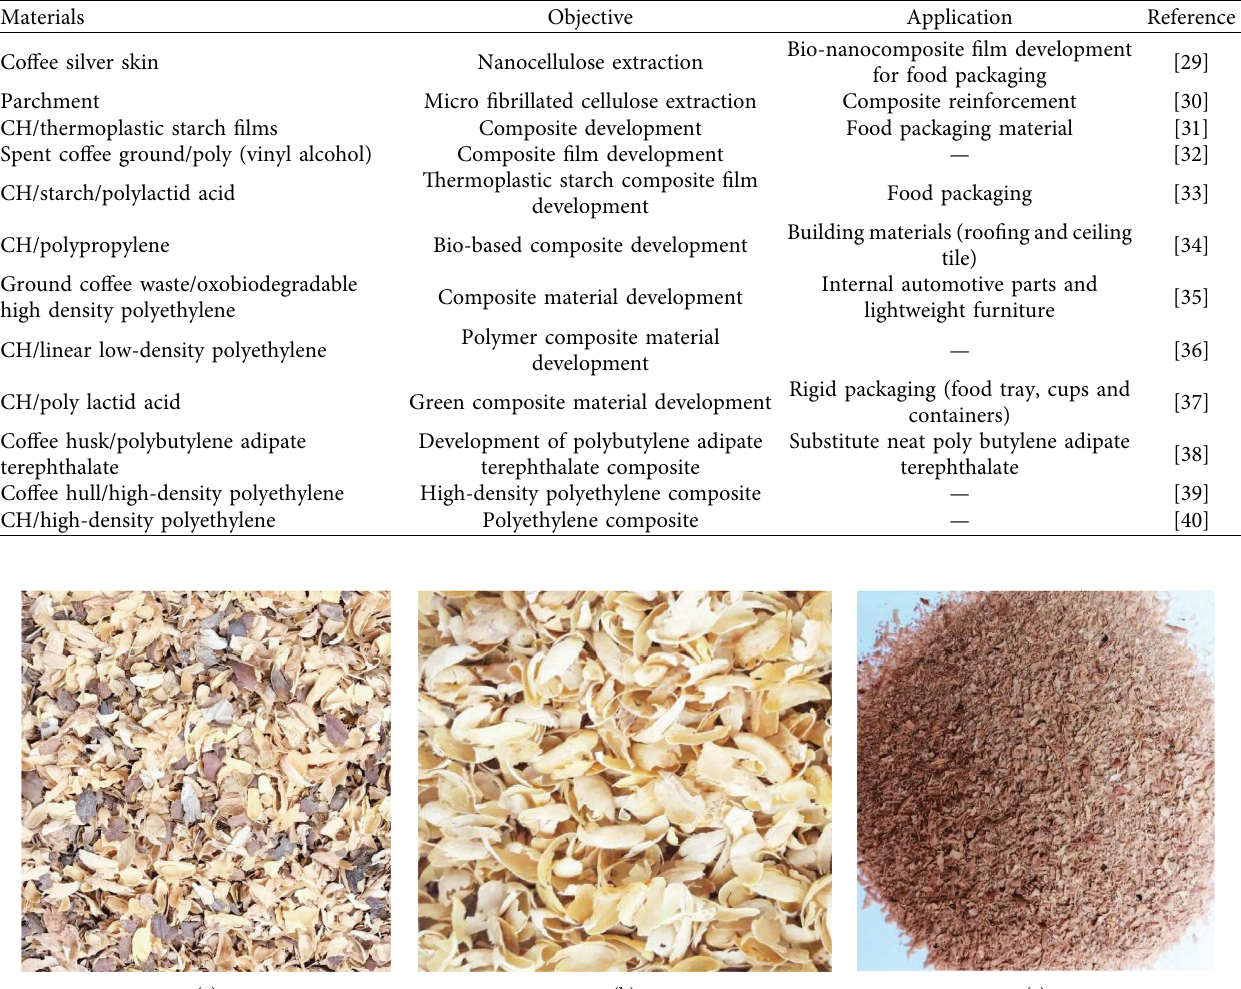
Table 1: Recently reported research work conducted on cofee industry residues.